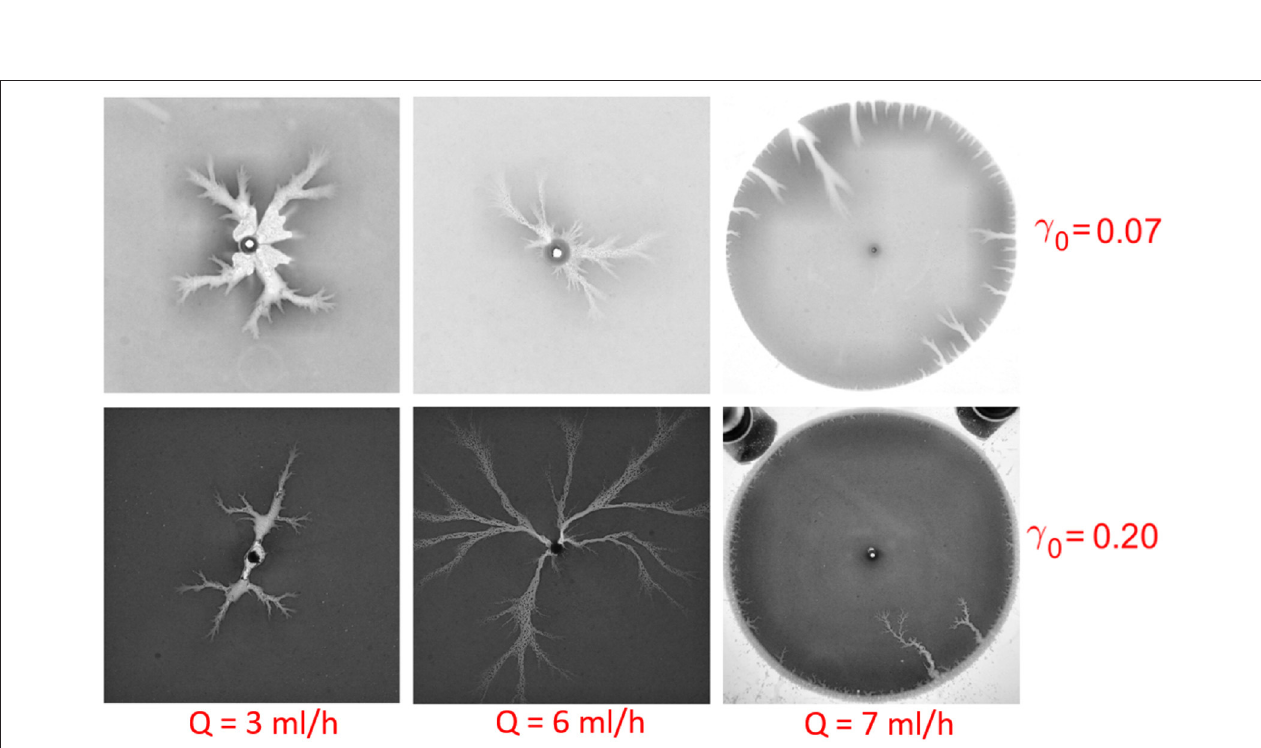
FIGURE 7 | Ramified or smooth fingers with different initial roughness γ 0 and injection rate Q . From top to bottom, the roughness increases from γ 0 γ 0 0.20 for the initial average aperture h 0 50.0 µ m (top) and 150.0 µ m (bottom) , respectively. From left to right, the flow rate is Q = = respectively. Notice that the rightmost two dissolution patterns are obtained in the withdrawing experiments. We observe that as the roughness is increased, the patterns become thinner and more